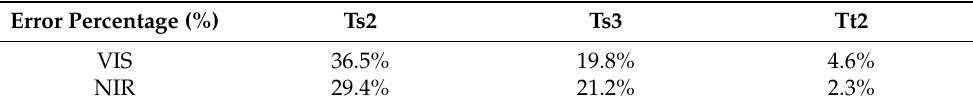
Table 10. Statistics of average error percentages for continuing monitoring of stream water turbidity verified by different lighting